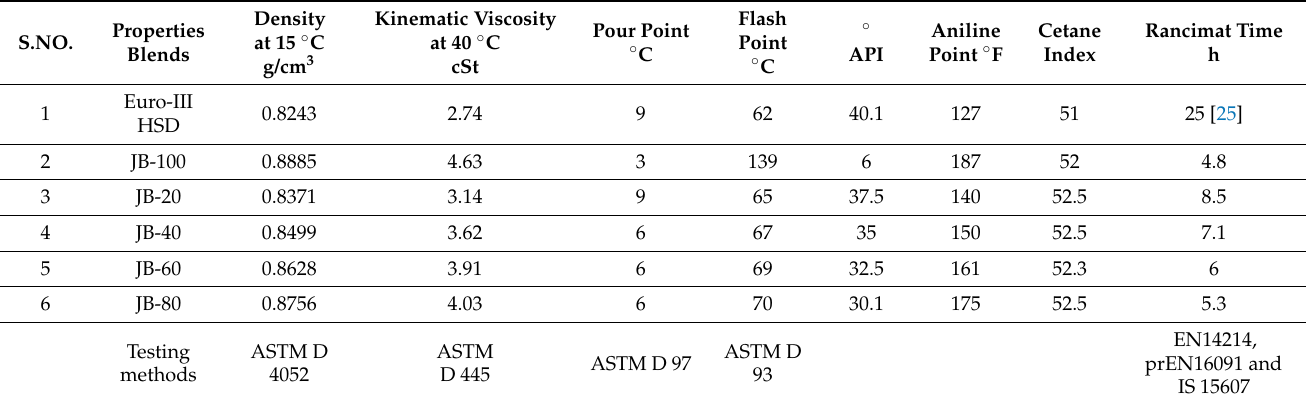
Table 5. Physical and chemical properties of EURO-III HSD and Jatropha curcus methyl ester blends (JB+E-III).